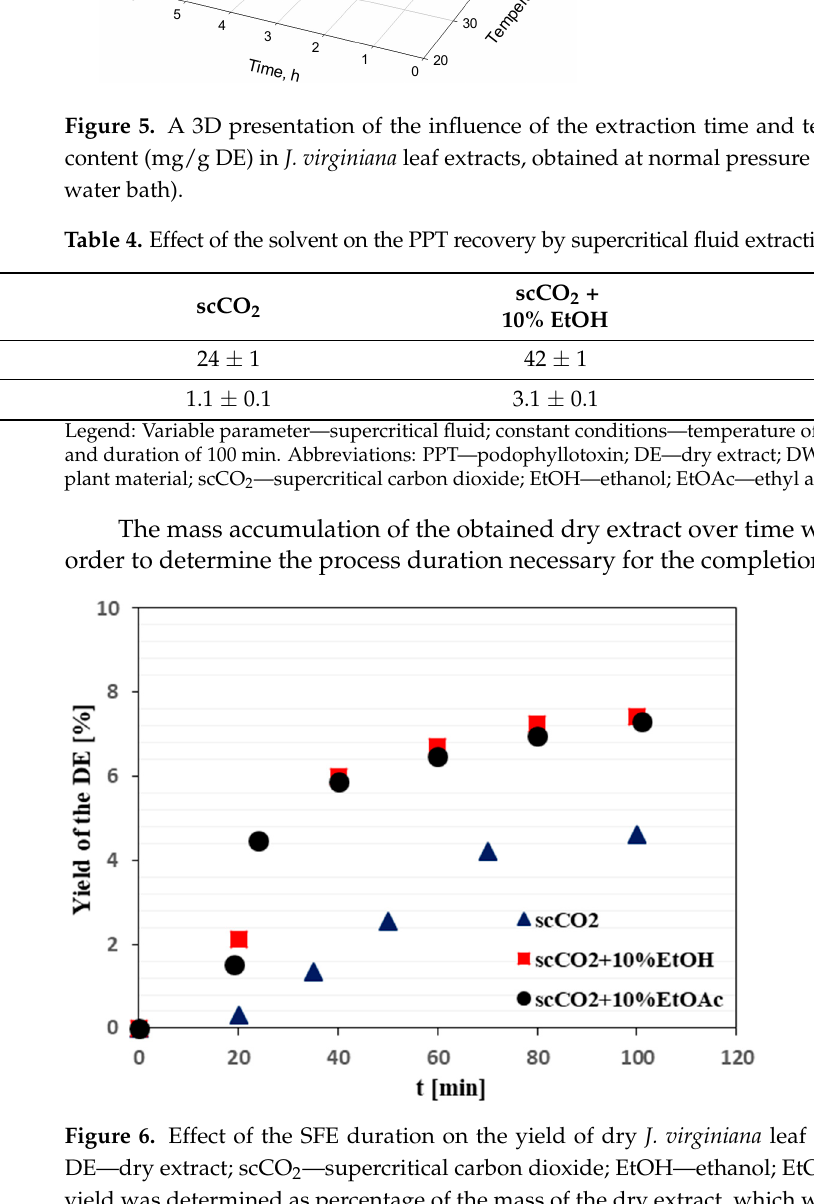
SFE process, over the mass of the dry starting plant